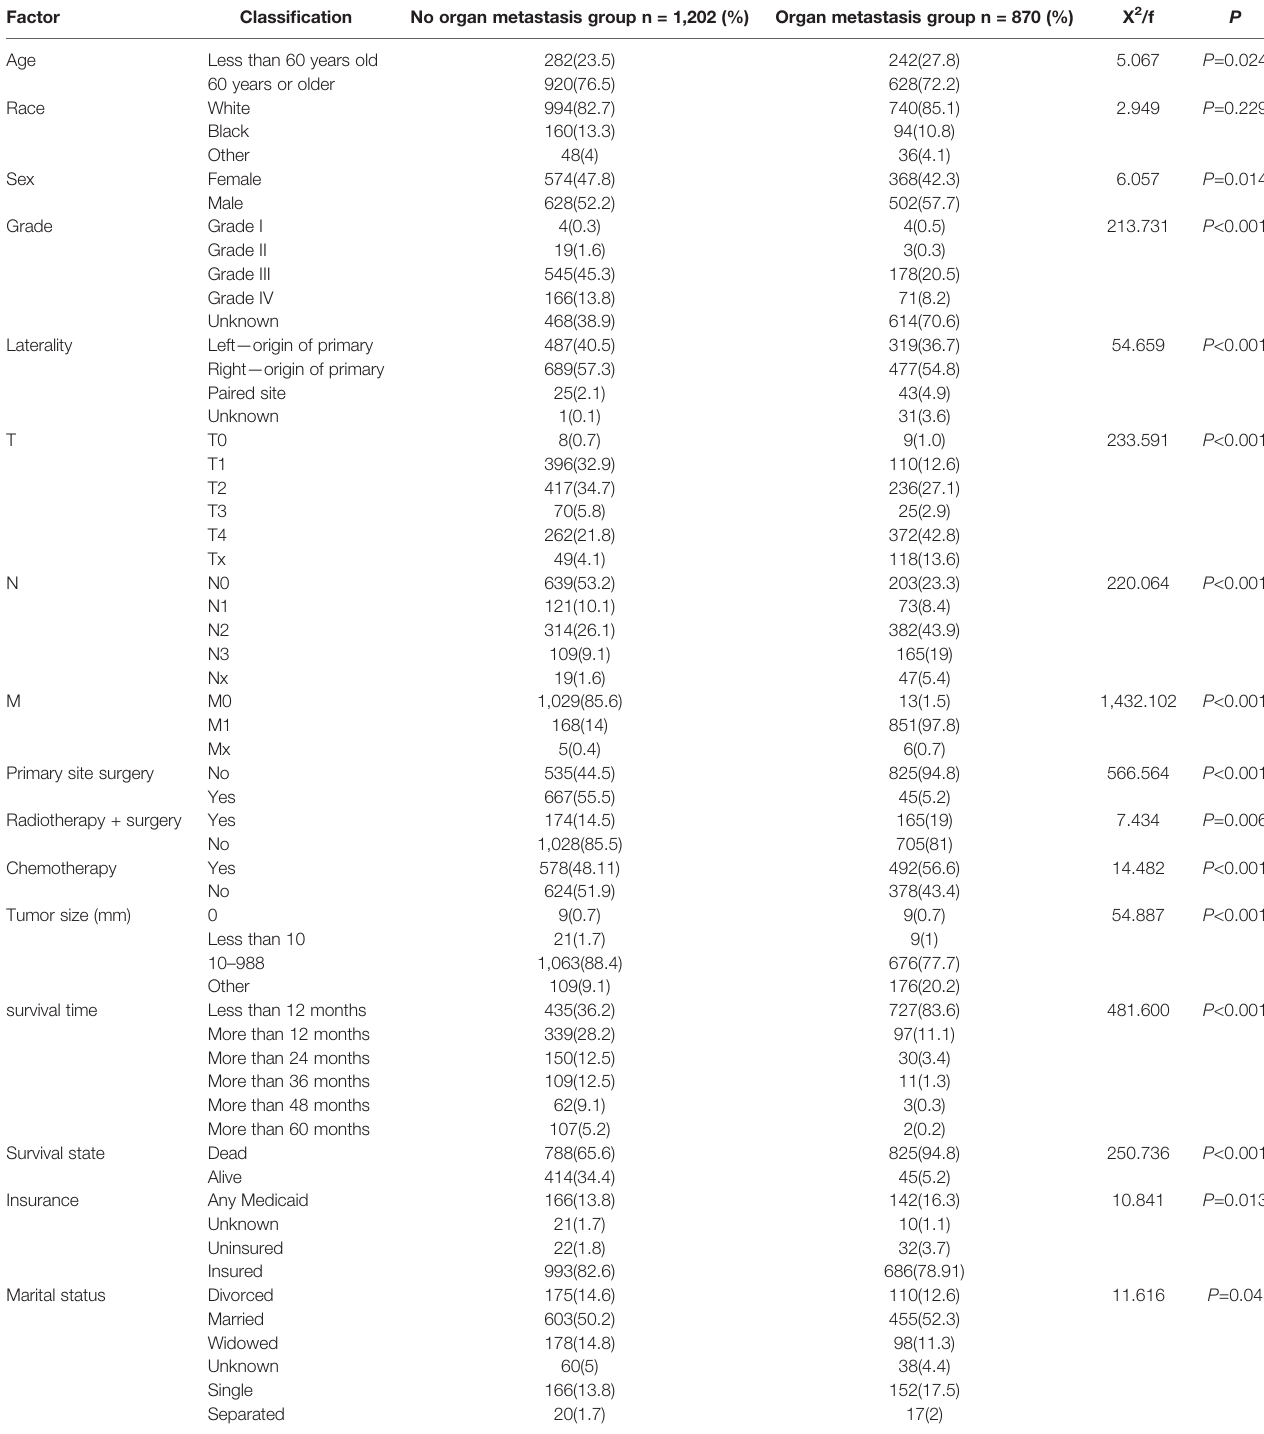
TABLE 2 | Basic clinicopathological